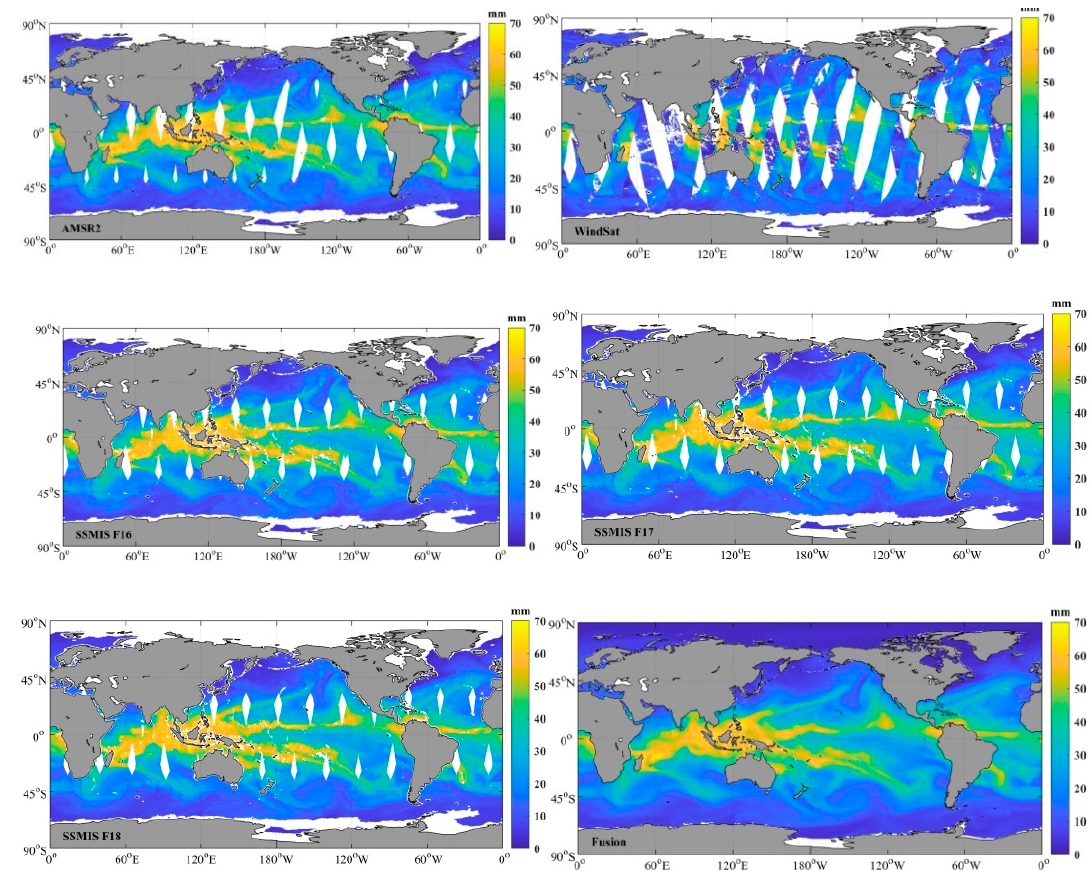
Figure 4. Comparison of water vapor fusion data and single spaceborne radiometer data on 1 January 2018. The white areas in the middle and low latitudes in Figure 4 are areas that cannot be observed by satellites. The observation ability of spaceborne radiometers in polar regions is poor due to the influence of sea ice.